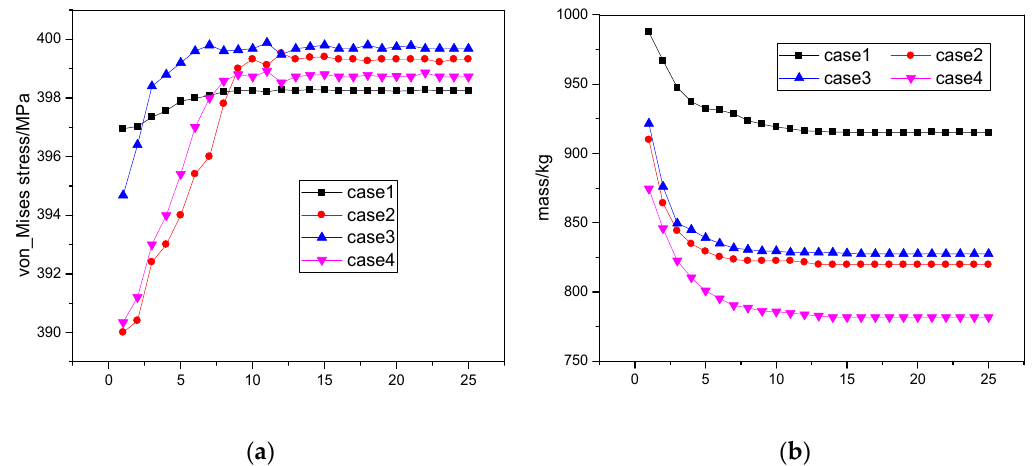
Figure 13. Iteration histories of the von-Mises stress and the mass. ( a ) Iterations of the von-Mises stress ( b ) Iterations of the mass.